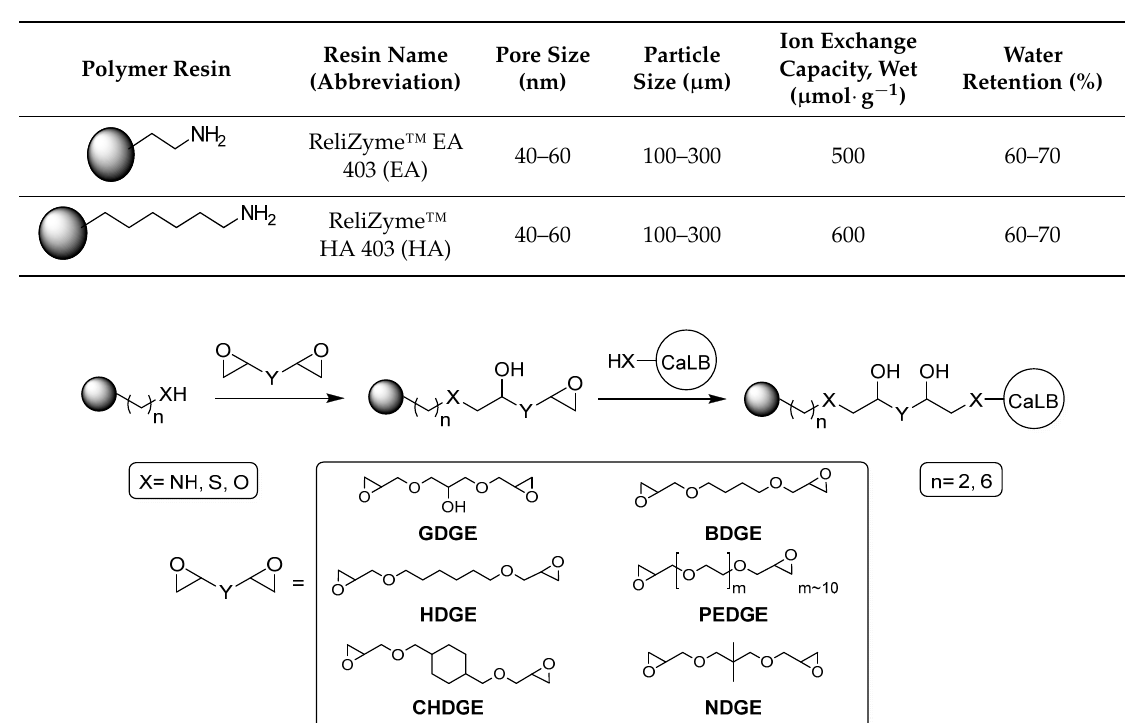
Figure 1. Bisepoxide activation of supports for immobilization of Ca LB.